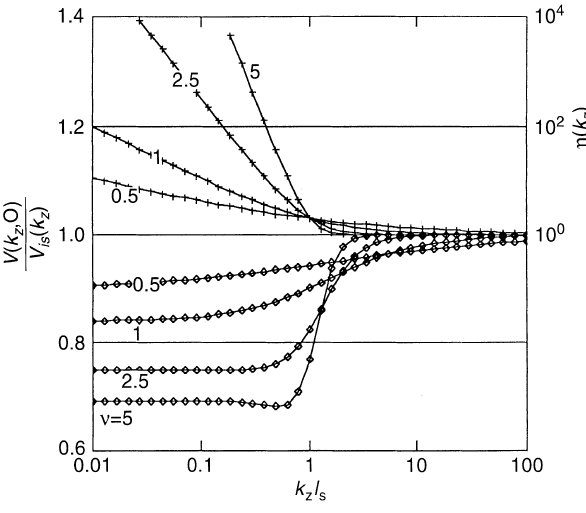
Fig. 3. The 1D vertical spectra V (cid:133) k z ; 0 (cid:134) of LASIs normalized to the 1D spectrum of LI inhomogeneities V is (cid:133) k z (cid:134) with the same GE spectrum E (cid:133) q (cid:134) (cid:136) q (cid:255) 3 ( diamonds ); anisotropy coe(cid:129)cients (cid:103) (cid:136) 1 (cid:135)(cid:133) ql z (cid:134) (cid:255) (cid:109) ( crosses ), q (cid:136) k z ; the numbers in the plots are the values of